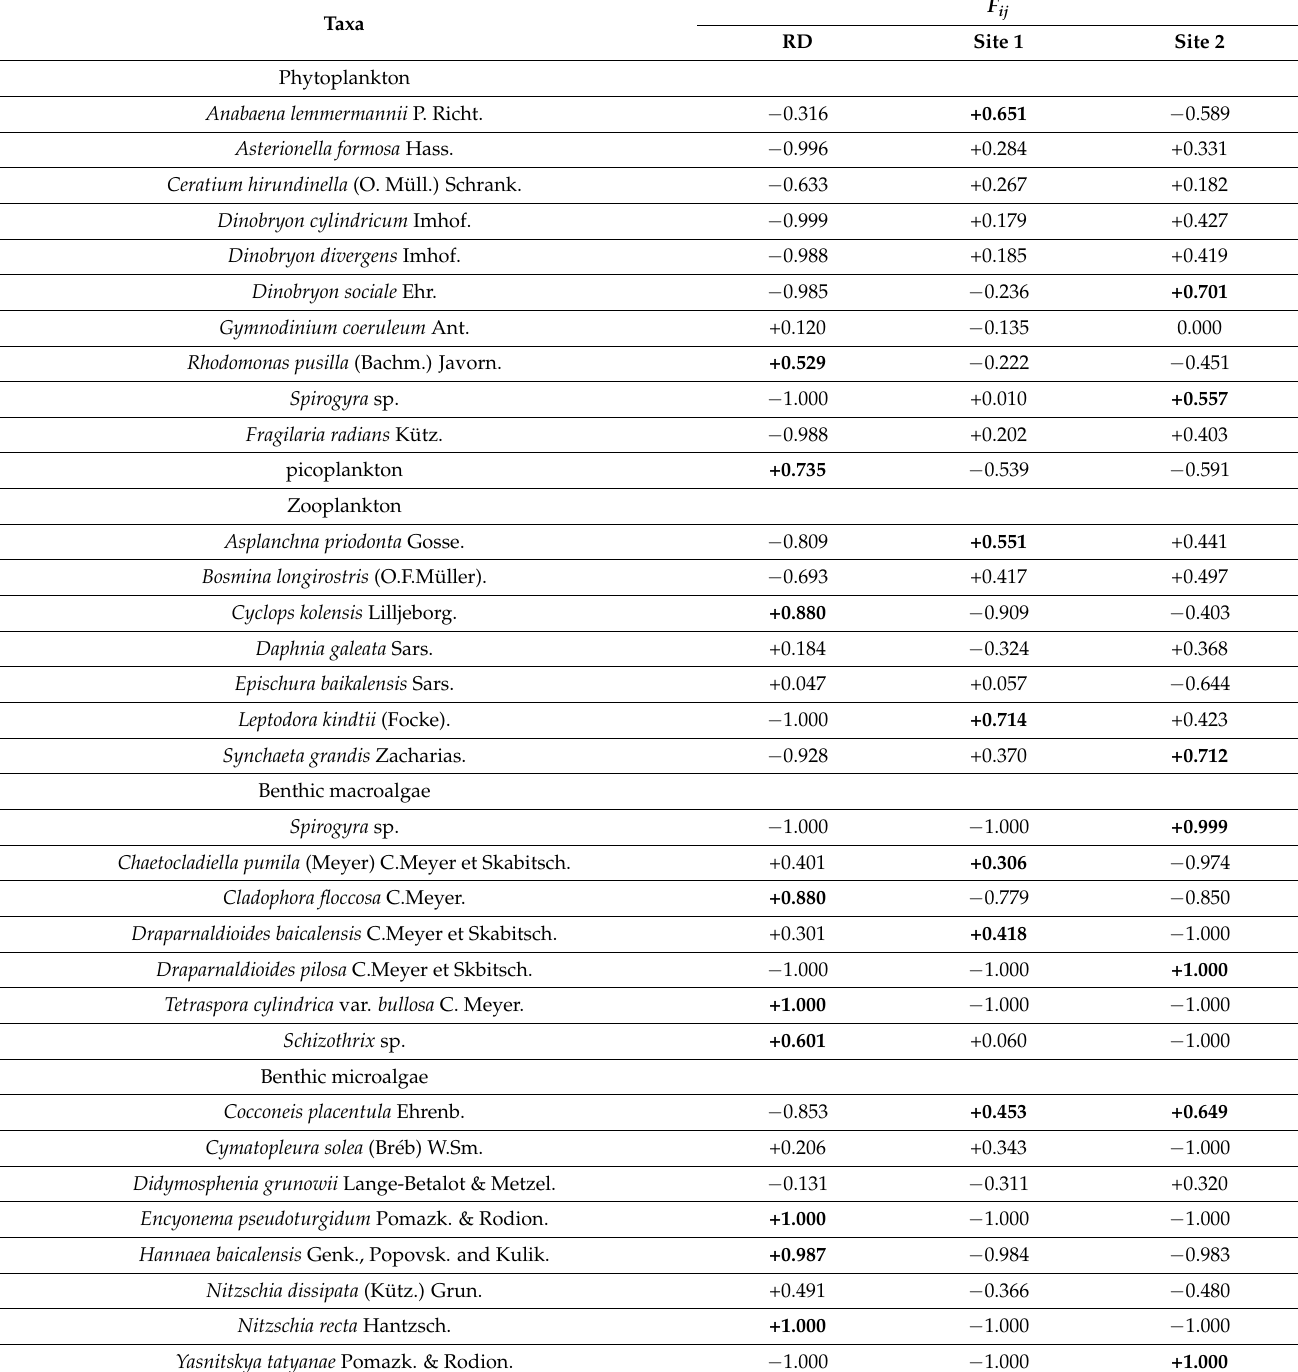
Table 2. Index of biotope confinement of dominant species of aquatic organisms to the studied areas in the coastal zone of Lake Baikal: RD—reference data, Site 1—background area, Site 2—area with human activity in Listvennichny Bay; the maximum positive F ij values are in